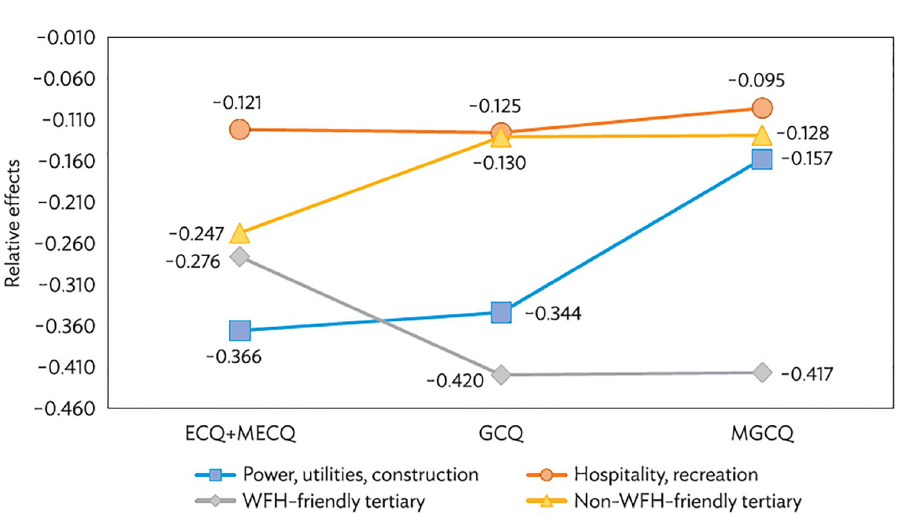
Fig 5. Differential effects of lockdown measures on cities of different industrial corporation. ECQ = enhanced community quarantine; GCQ = general community quarantine; MECQ = modified enhanced community quarantine; MGCQ = modified general community quarantine; WFH = work-from-home. Source: Authors’ calculations (see column “Model 3” in Table 2A).